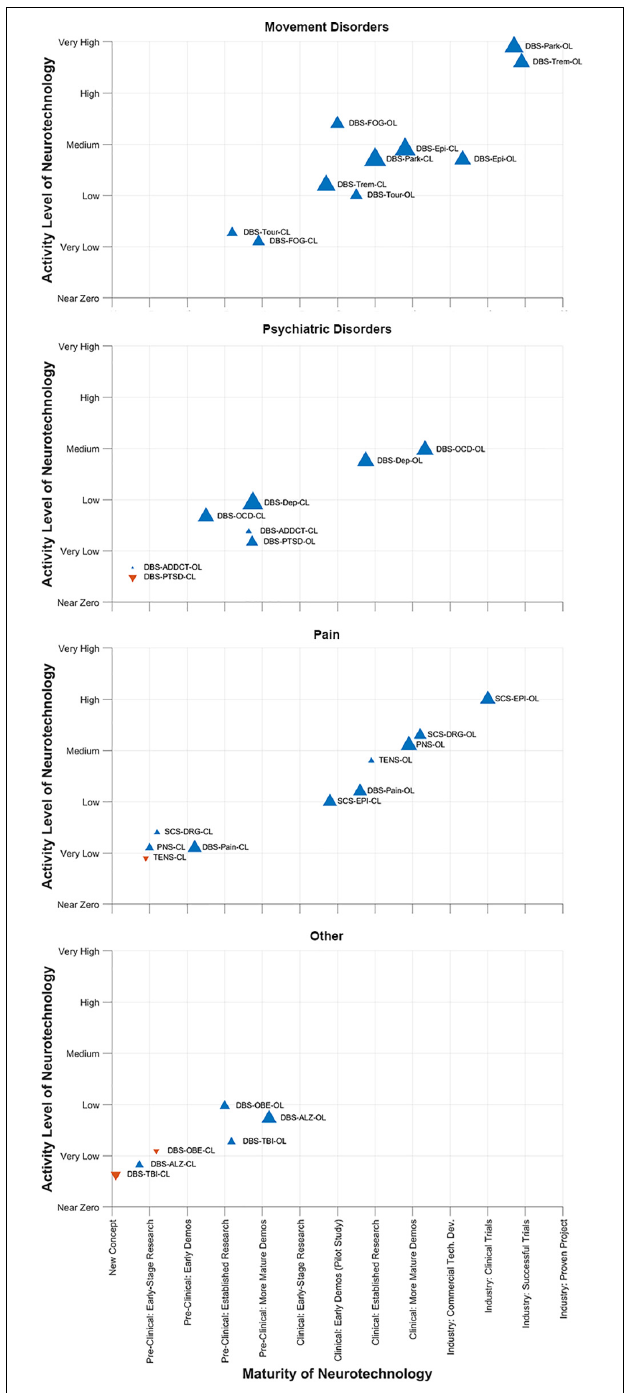
FIGURE 12 | DBS-Think-Tank Neurotechnology Activity-Maturity Graphs. This figure presents four graphs that illustrate the perceptions of DBS-Think-Tank attendees about the maturity, activity, and change in activity of a variety of neurotechnologies. The neurotechnologies are organized into the following four groups and graphed separately: movement disorders, psychiatric disorders, pain disorders, and other syndromes. The upward pointing blue triangles represent increasing activity and downwards pointing orange triangles represent decreasing activity. The magnitude of the change is